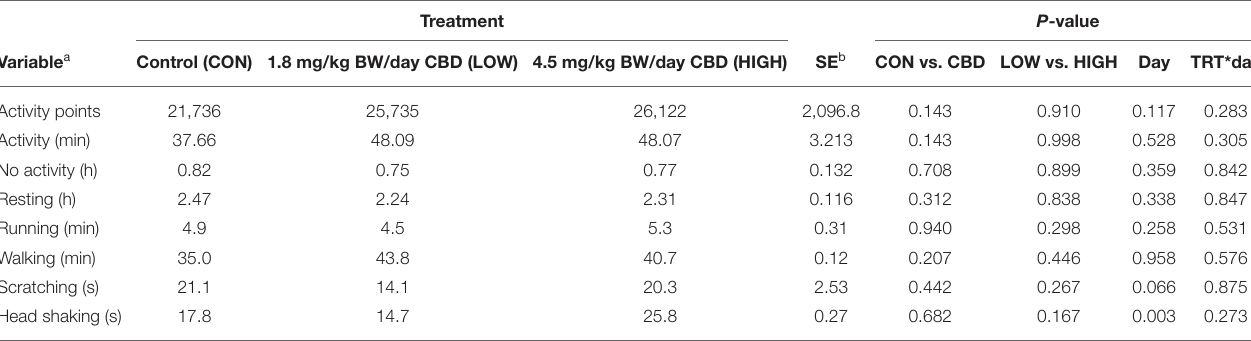
TABLE 5 | Effect of treatment (TRT), day, and TRT * day interactions on activity parameters collected via Vetrax ® activity sensors (AgLogica Technology, Norcross, GA) during the two periods of daily exercise, which included all data from 0700–0900 to 1,700–1,900h each day. Treatment P -value Variable